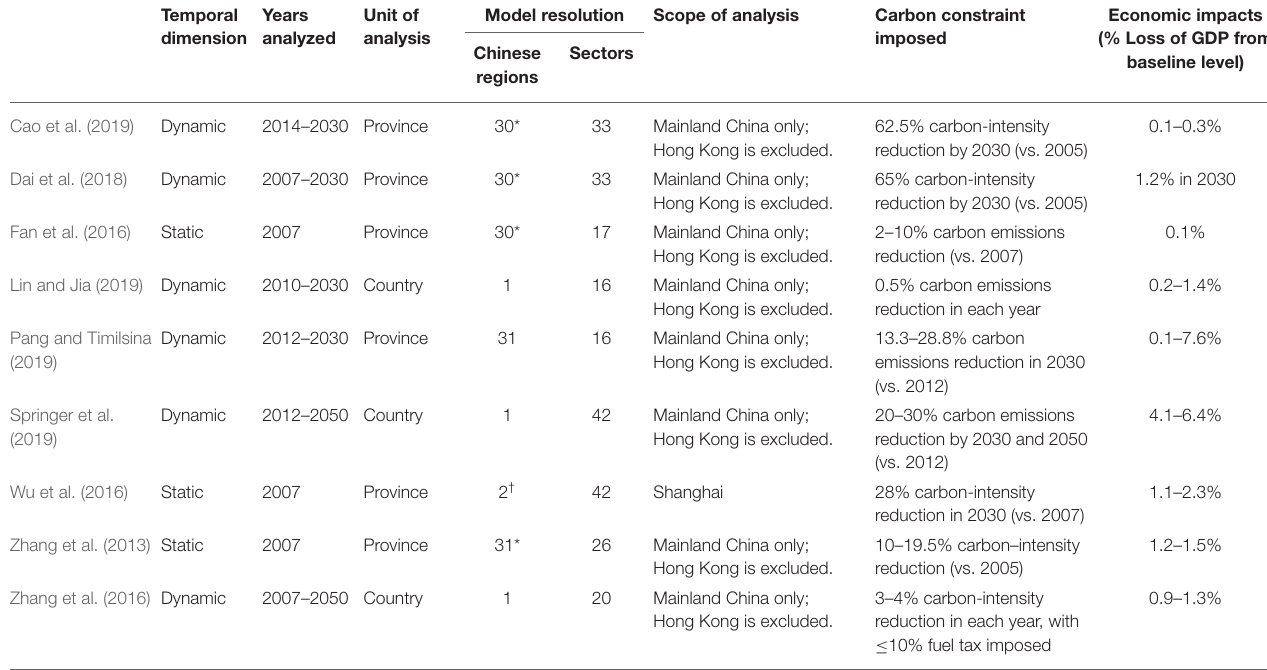
TABLE 1 | CGE Studies on China’s